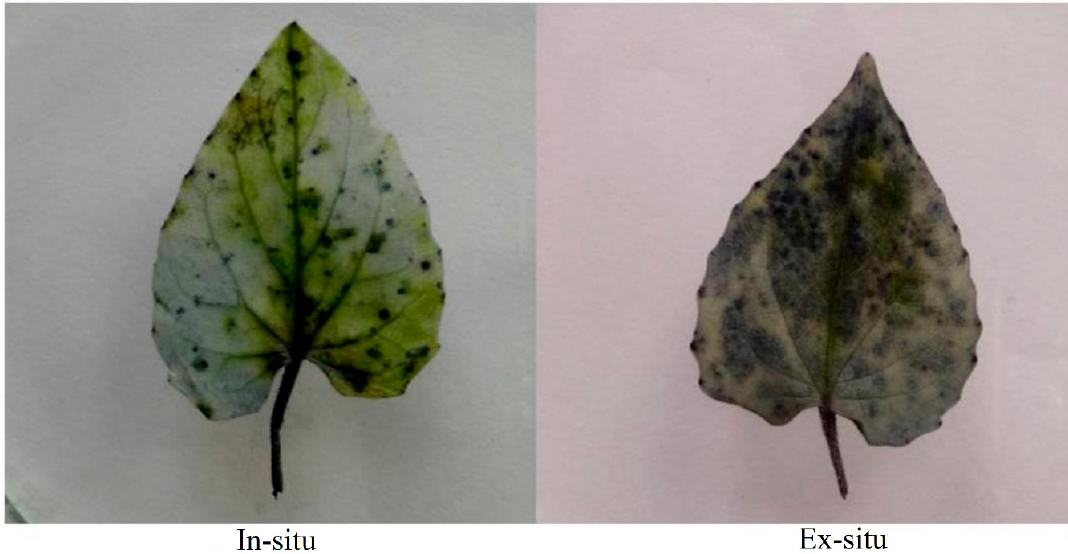
Figure 1. Superoxide ions in in-situ and ex-situ grown plants of Valeriana wallichii .